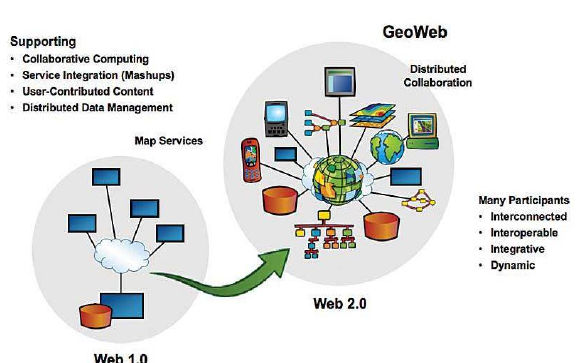
Figure 9: Example of web-map infrastructure revolution from single organization uses to collaborated system (ESRI,